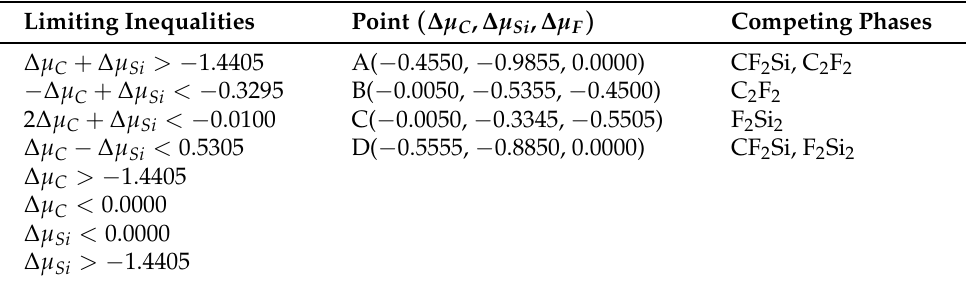
Table 1. The limiting inequalities applied to the independent variables ∆ µ C and ∆ µ Si . The point column lists the intersection points bonding the stability region. The corresponding values of the dependent variable ∆ µ F and the relevant competing phases are also given. All energies are in eV.